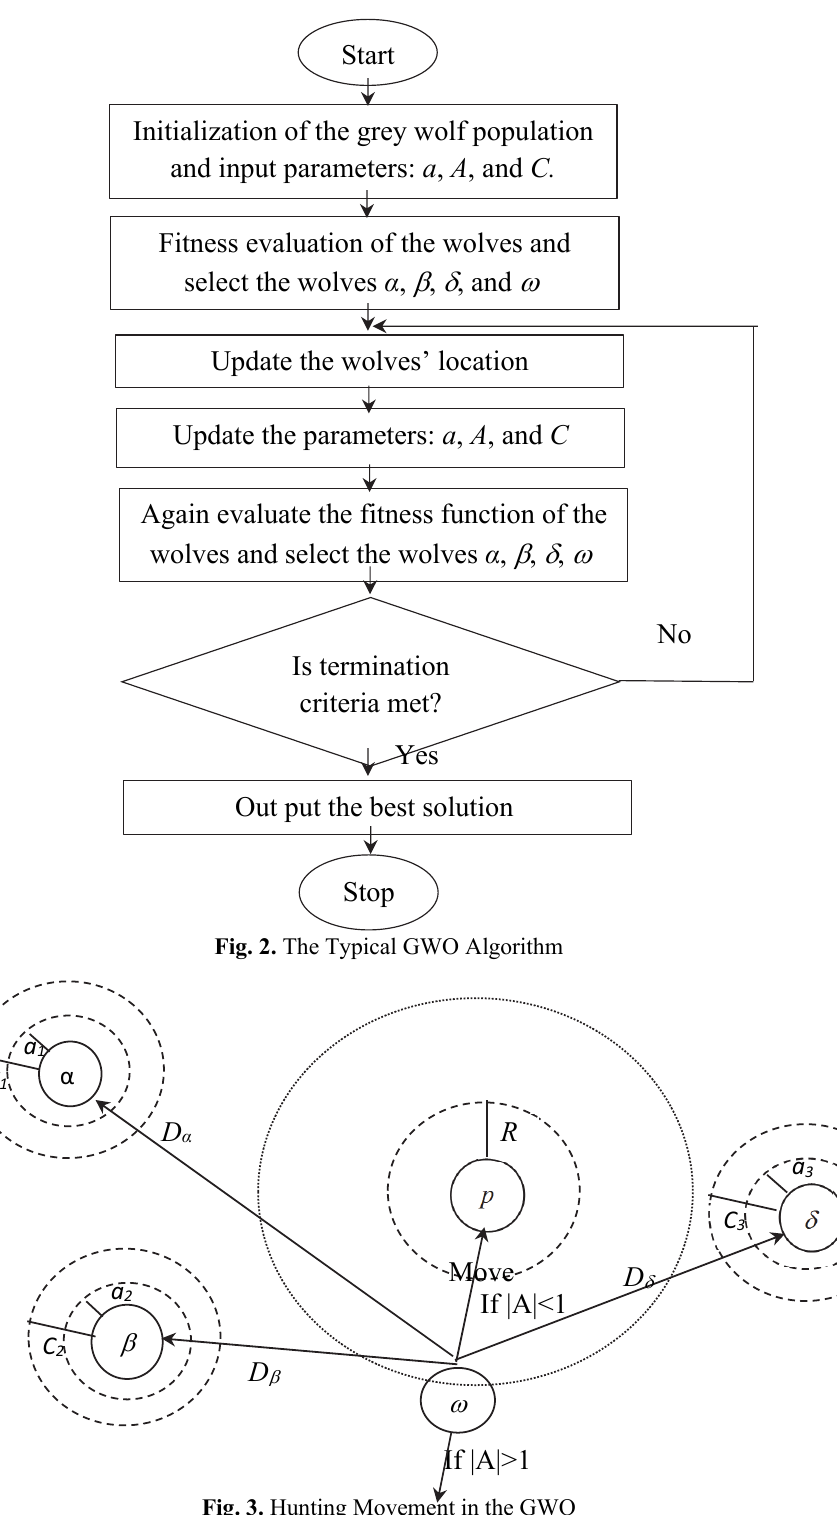
Fig. 3. Hunting Movement in the